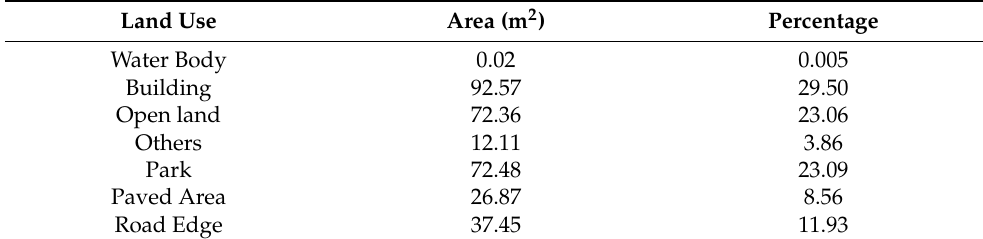
Table 2. Land use/Land cover of Hauz Khas Ward